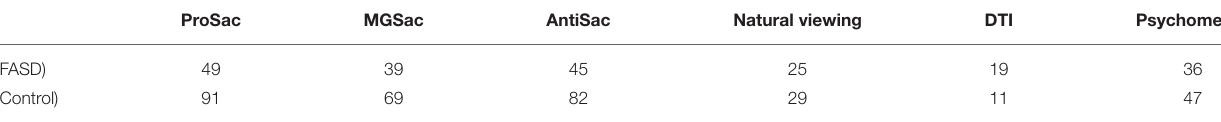
TABLE 3 | Participants for training single assessment classifiers. ProSac MGSac AntiSac Natural viewing